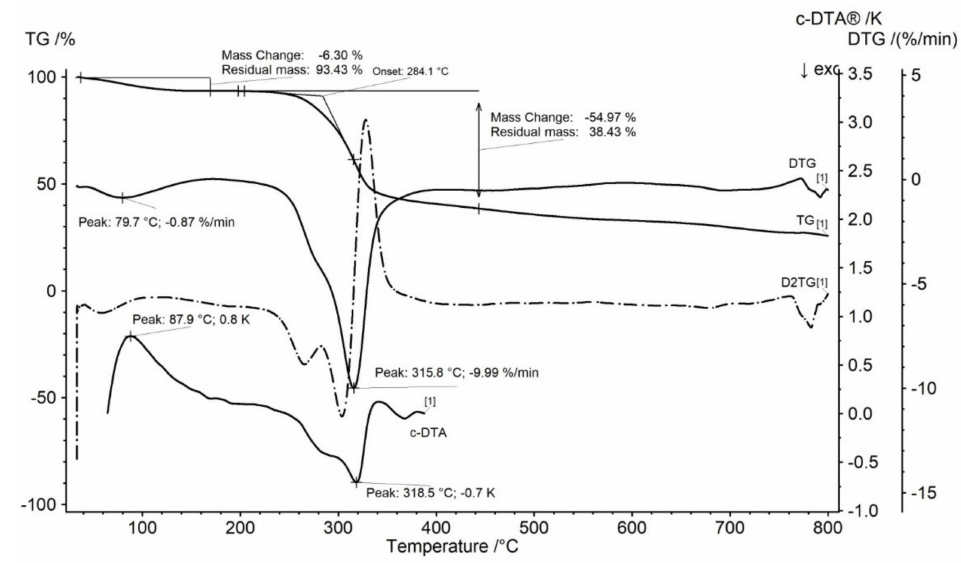
Figure 1. TG, DTG, D2TG, and c-DTA curves of gum arabic (GA). Curves recorded for dynamic thermogravimetric measurement.